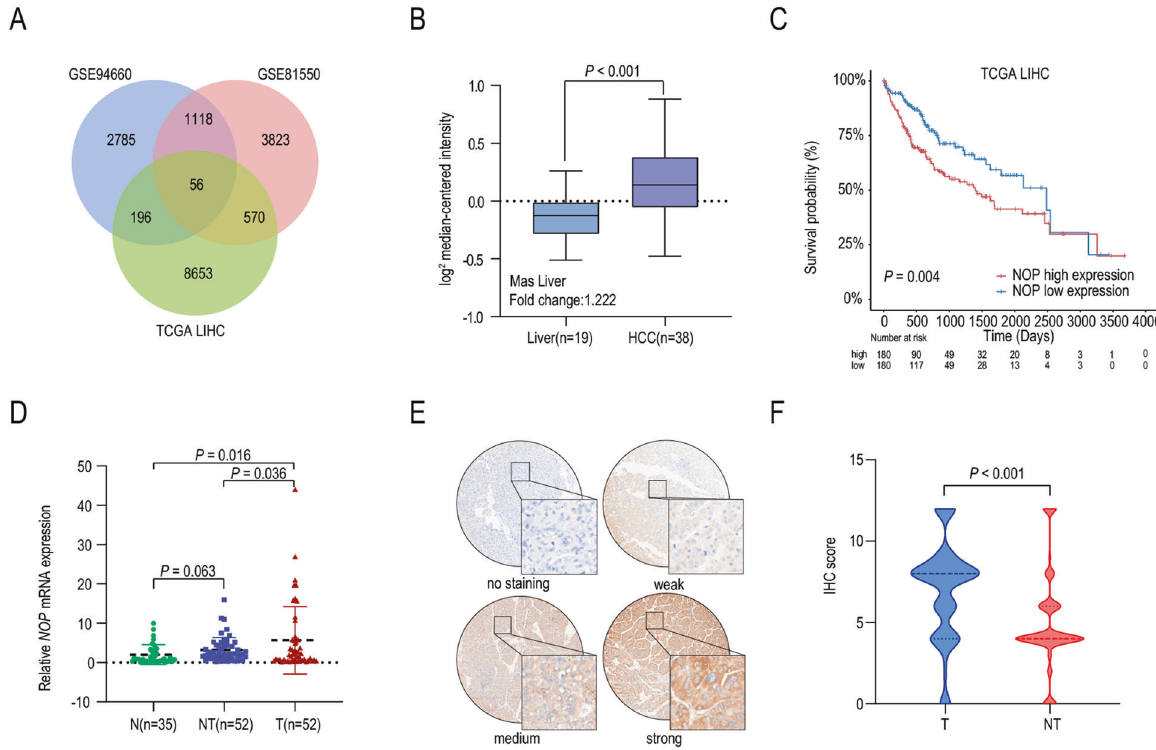
Fig. 1 NOP is upregulated and predicts poor prognosis in HCC. A Venn diagram of the differentially expressed genes in three HCC datasets. B Boxplots of NOP mRNA expression in HCC ( n = 38) and adjacent tissue ( n = 19) in the Mas Liver dataset. C Kaplan – Meier analysis based on NOP expression in the TCGA dataset ( n = 360). D Boxplots of NOP mRNA expression in normal tissue (N) ( n = 35), HCC (T) ( n = 52), and adjacent tissue (NT) ( n = 52) in the SYSUCC cohort. E IHC staining showing strong, moderate, and weak positive expression and negative expression of NOP in HCC. Scale bar: ×4 = 100 μ m; ×40 = 10 μ m. F Boxplots of the IHC score of NOP in HCC ( n = 288) and adjacent tissue ( n =